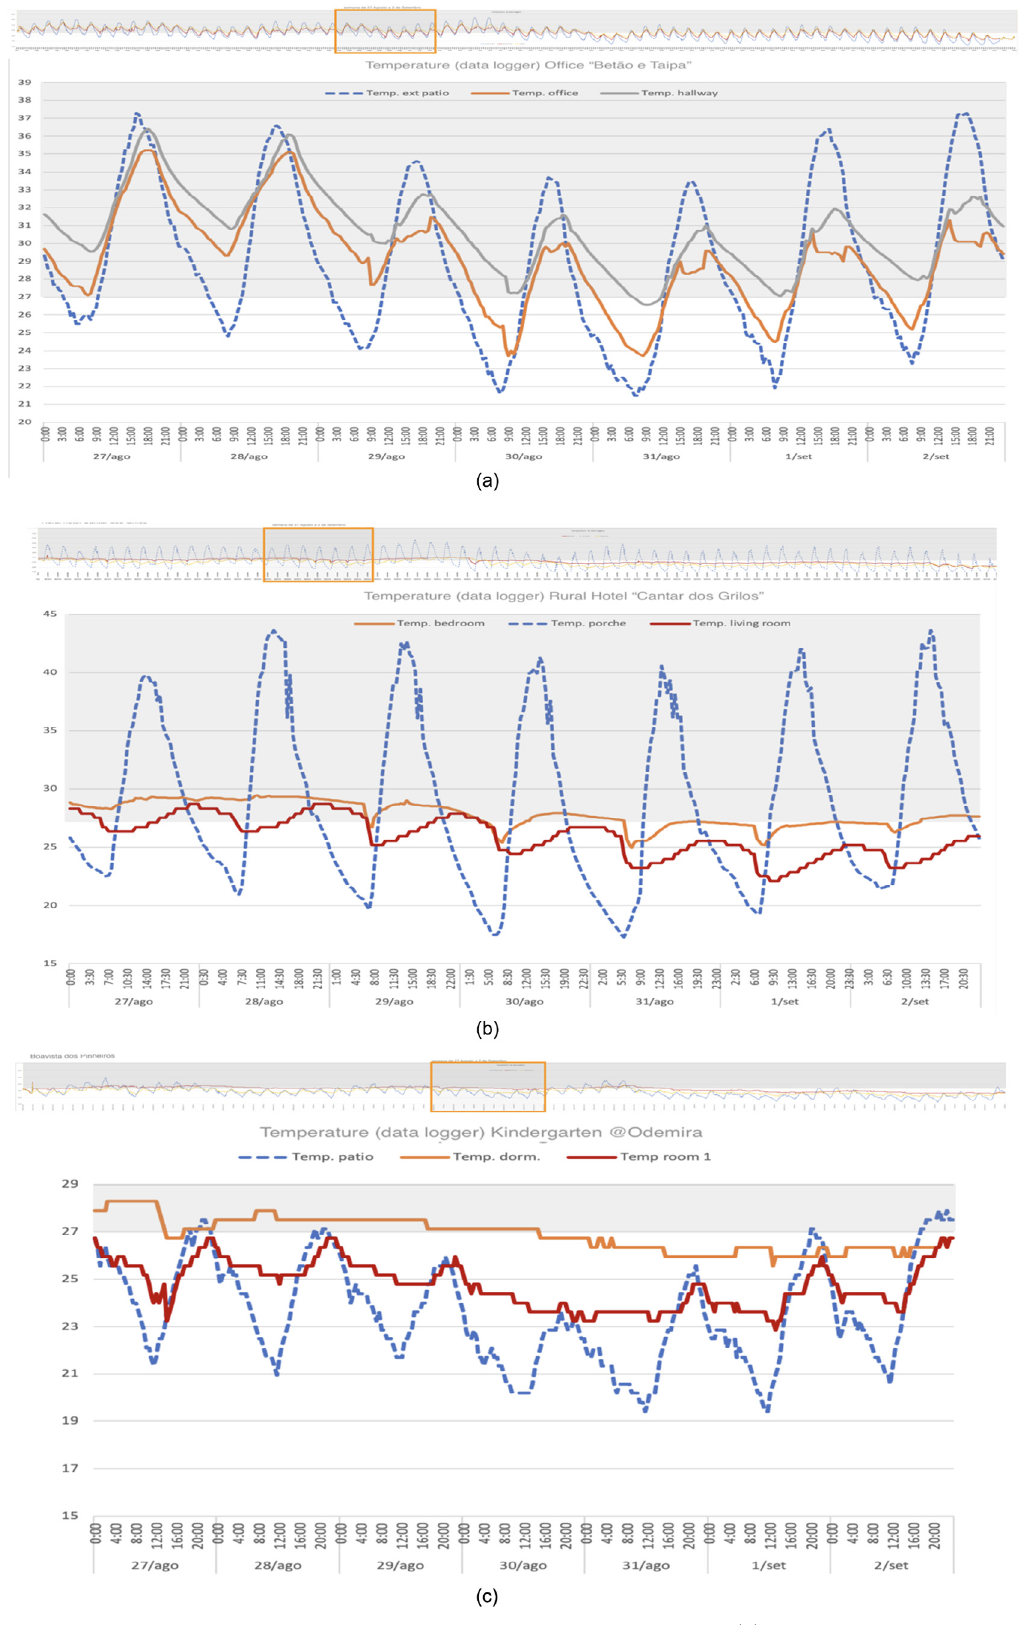
Fig. 5. Measurement recorded by data logger devices, with representative week analysis. (a) The architectural of fi ce “ Betão e Taipa ” , (b) The rural hotel “ Cantar dos Grilos ” , (c) Odemira Kindergarten